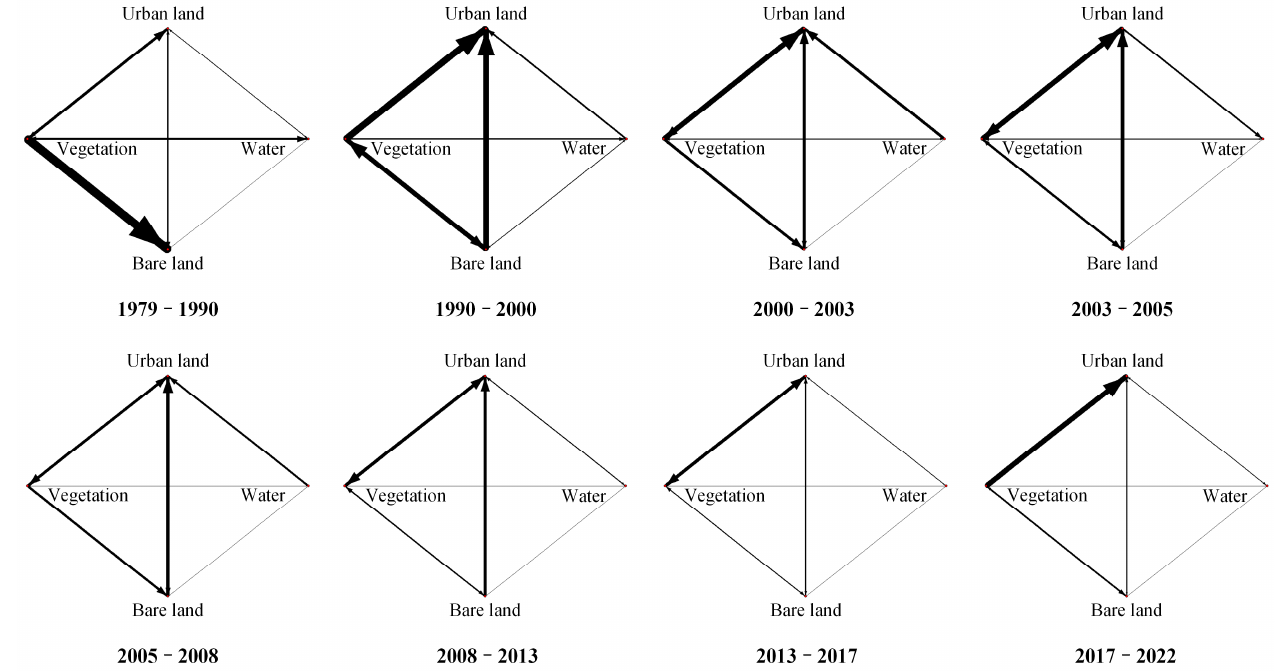
Figure 5. The complex network visualization of the land cover transformation in Shenzhen from 1979 to 2022.